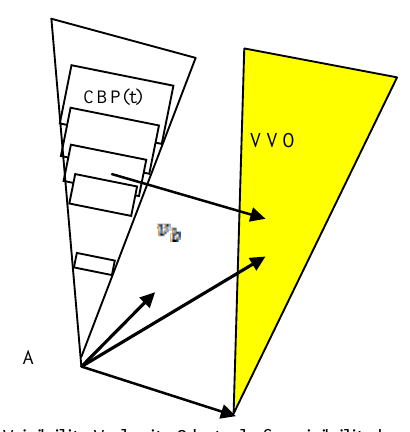
Figure 6. Visibility Velocity Obstacle for visibility boundaries consist of 3D boxes